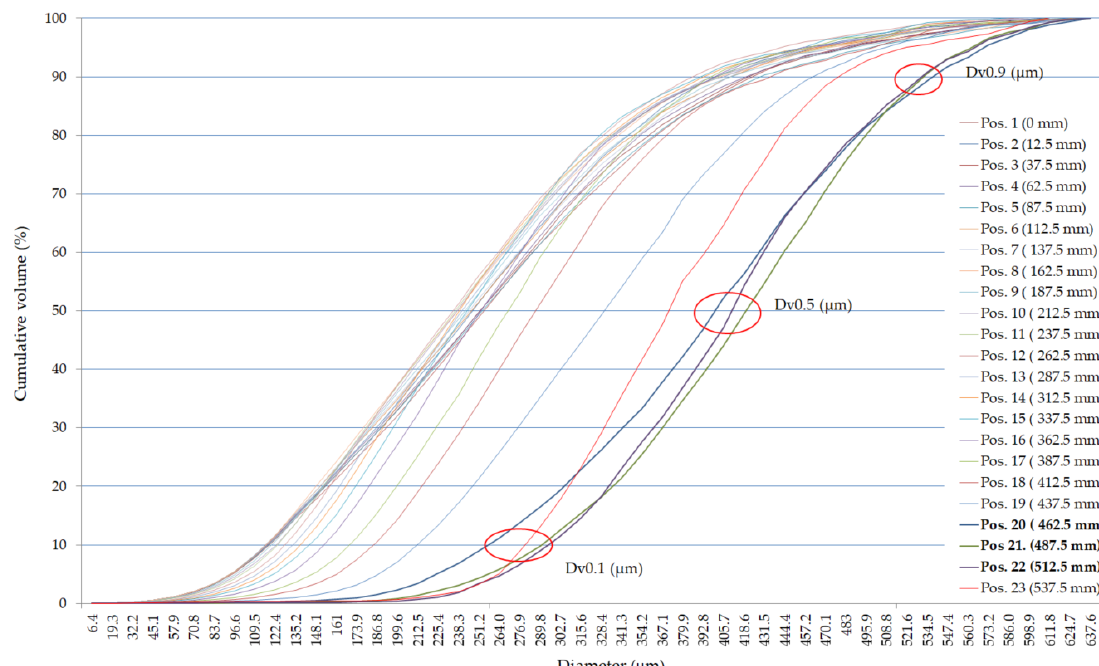
Figure 6. Cumulative percentage volumes for the left side of nozzle number 2.